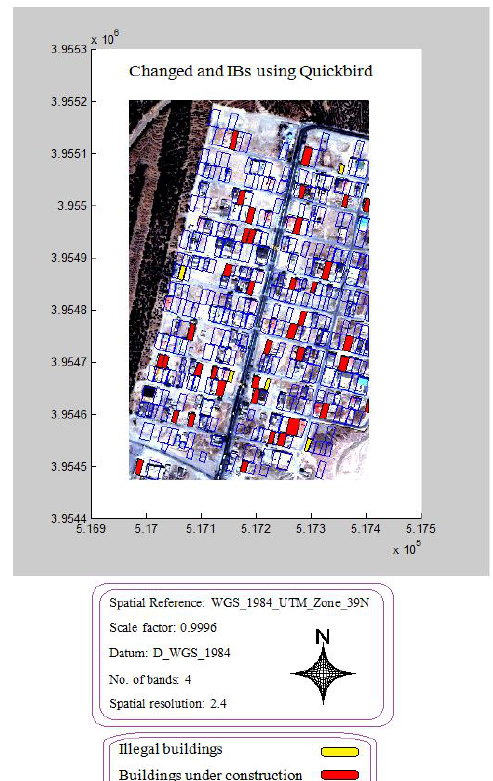
Figure 11. The detected under construction buildings and IBs using QuickBird satellite